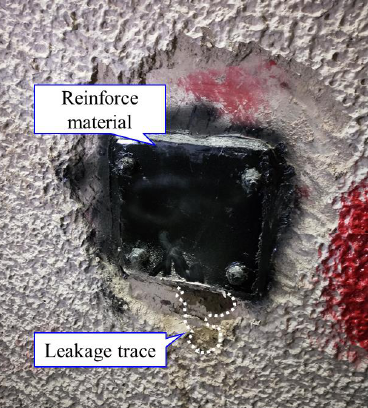
Figure 14. Reinforcement measures in the study site.